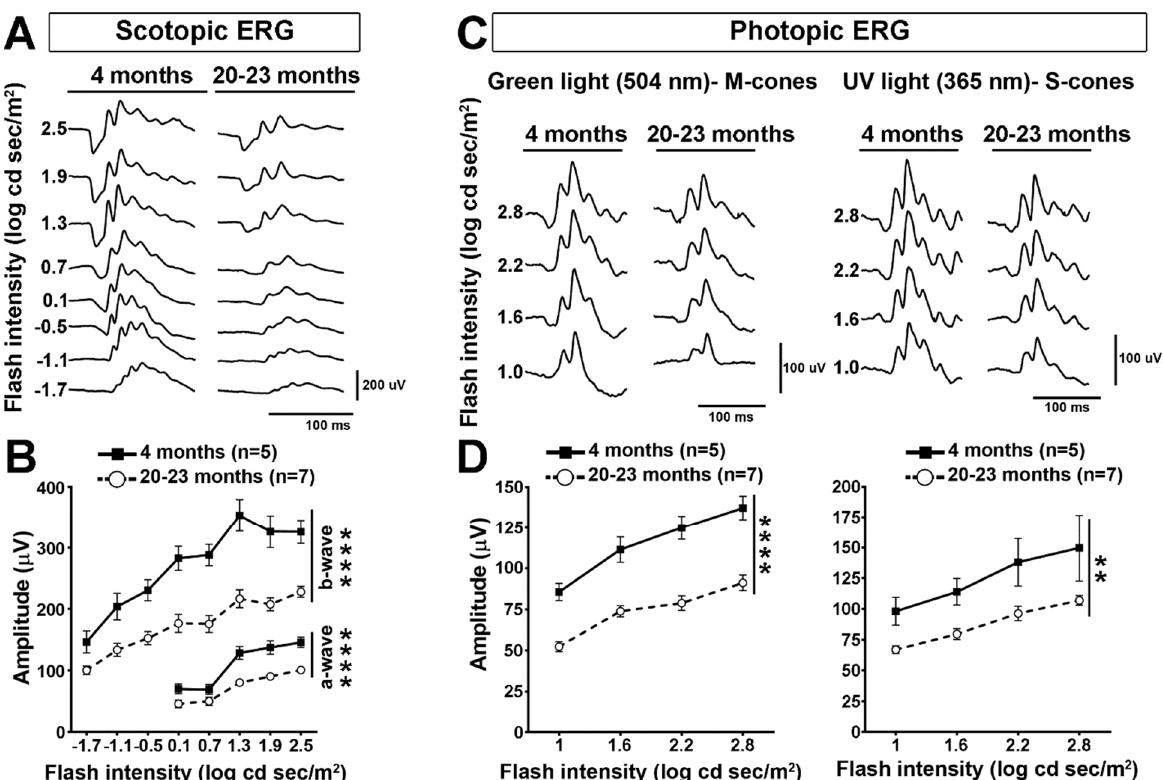
Figure 1. The retinal function decline in aging mice. Scotopic and photopic electroretinograms (ERG) were recorded at 4 and 23 months of age in C57BL/6J WT mice. ( A , B ) Scotopic ERG responses were weaker in old than in young mice for different intensities of light stimulation. Representative recordings are shown. Luminance–response curves were plotted for 5 young and 7 old mice. The amplitude of ERG a- and b-waves was statistically lower in old than in young mice (two-way ANOVA, Tukey post hoc test, ****: p < 0.0001). ( C , D ) In photopic conditions, M-cone- and S-cone-mediated ERGs were recorded with green and UV light flashes at 504 nm and 365 nm, respectively. Changes in b-wave amplitudes were measured and presented for different light intensities in luminance–response curves. The decreased b-wave amplitude revealed a significant loss of retinal activity after the stimulation of M-cones and S-cones with various intensities of light in old mice. The M-cone pathway turned out to be more affected by aging than that depending on S-cones (two-way ANOVA, Tukey post hoc test; **: p < 0.01, ****: p < 0.0001).